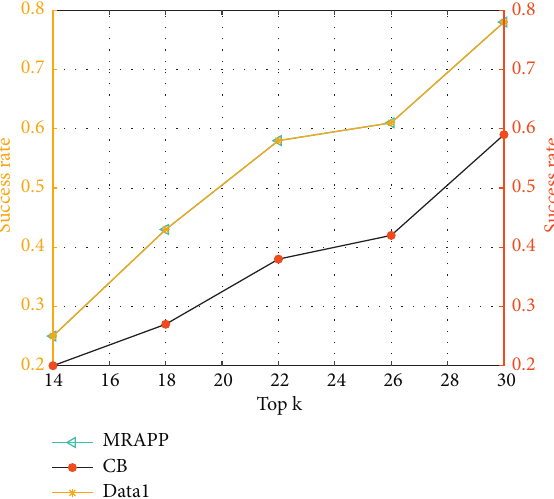
Figure 4: Comparison of recommendation success